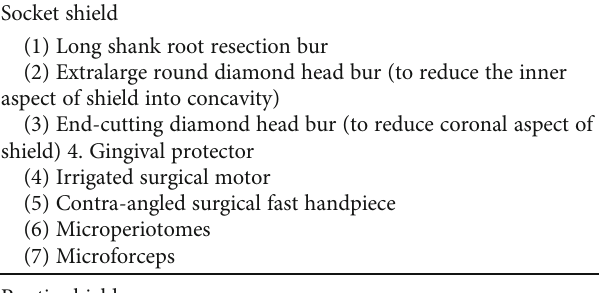
Table 2: Instruments and materials required for PET [8]. Socket